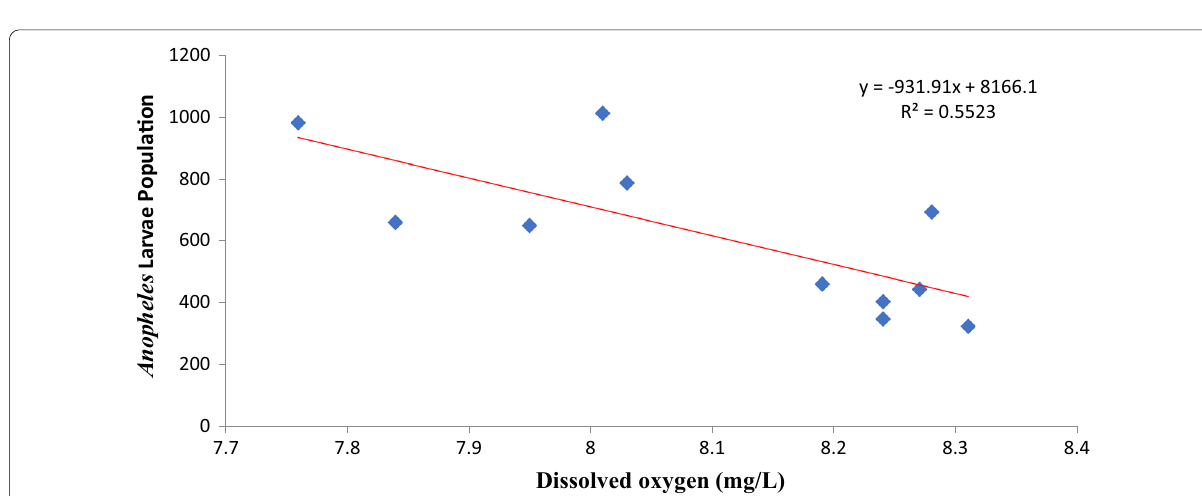
y = -931.91x + 8166.1 R² = 0.5523